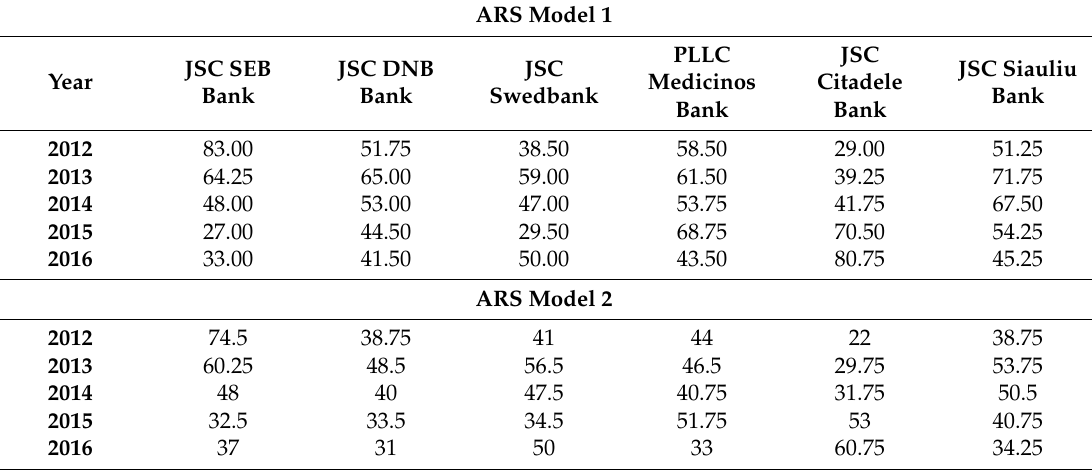
Table 5. The average risk score (ARS) excluding systemic risk (Model 1) and including systemic risk (Model 2). ARS Model